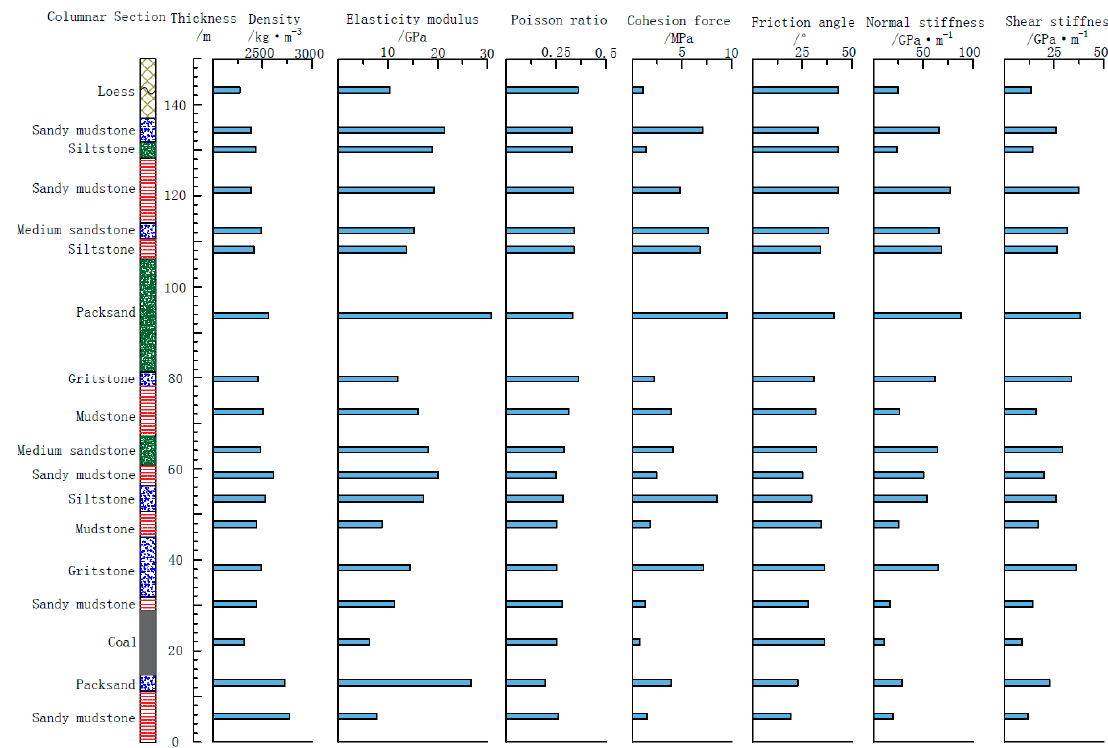
Figure 2. Composite column and mechanical parameters of working face 1313.